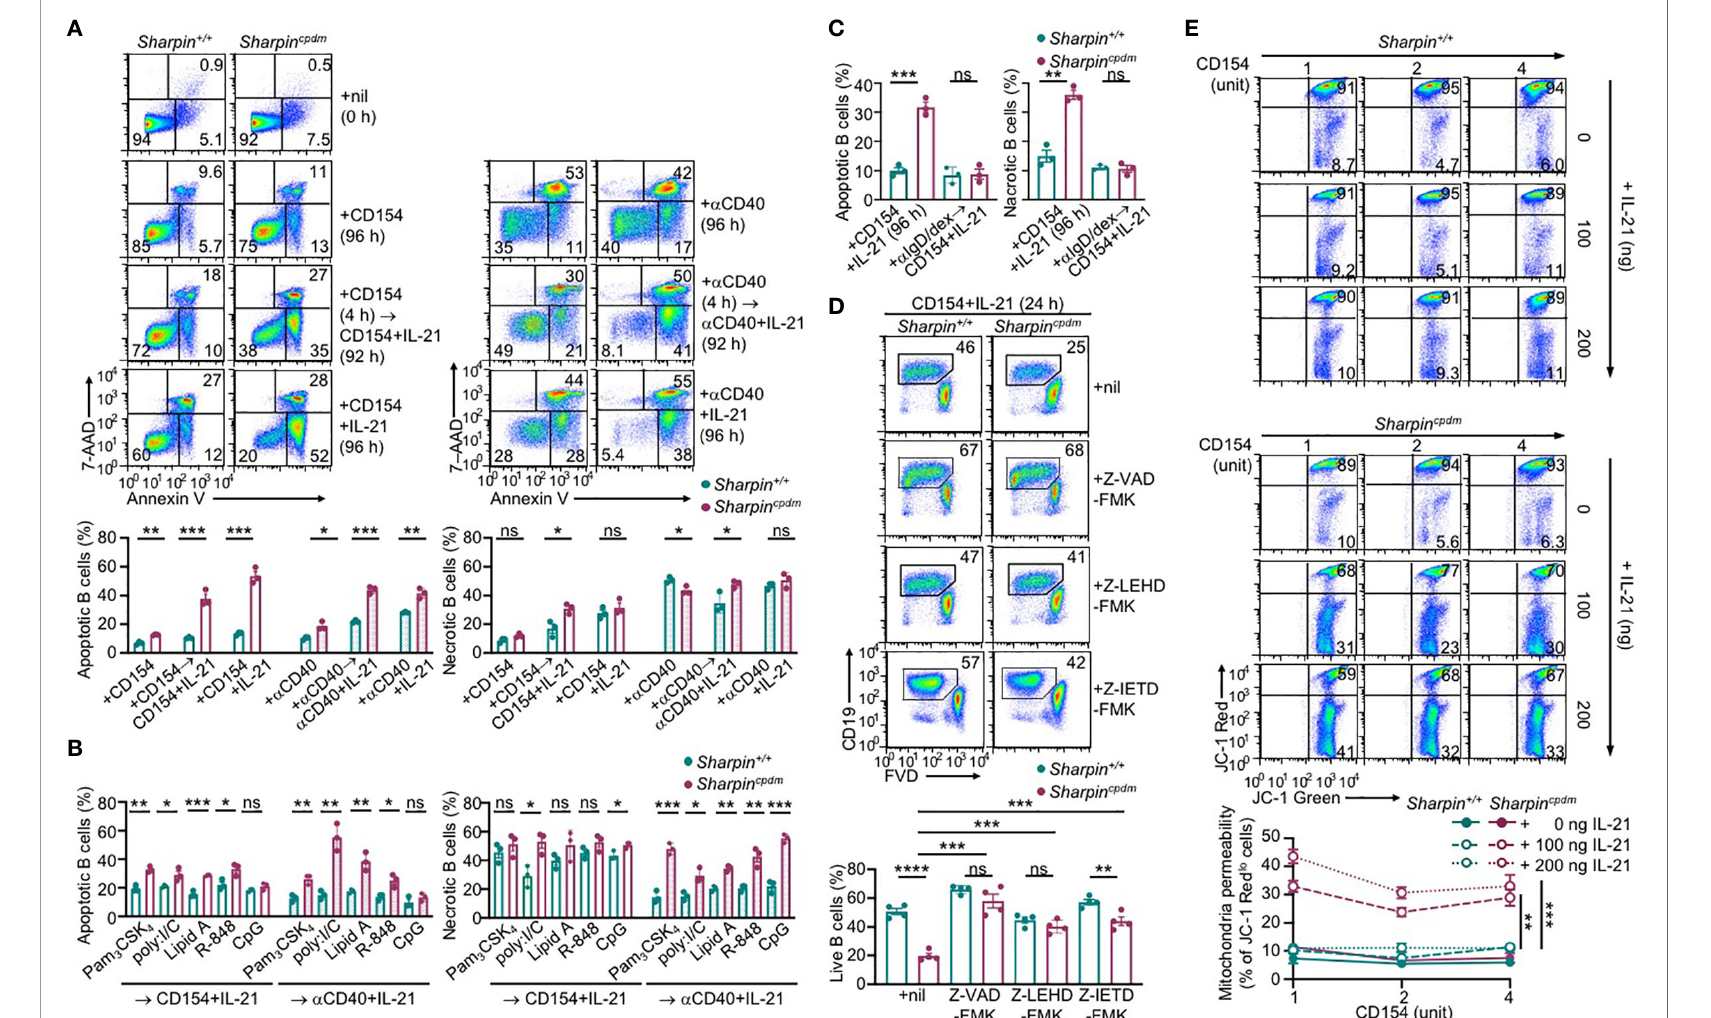
FIGURE 6 | SHARPIN inhibits IL-21-induced apoptosis in CD154-stimulated B cells. (A) Flow cytometry analysis of apoptosis (Annexin V + 7 – AAD lo ) and necrosis (Annexin V + 7 – AAD hi ) in freshly isolated Sharpin +/+ and Sharpin cpdm B cells or after stimulation with CD154 (left) or a CD40 (right) plus nil or IL-21 for 96 h, with or without priming with CD154 or a CD40 for 4 h. (B, C) Flow cytometry analysis of apoptosis and necrosis in Sharpin +/+ and Sharpin cpdm B cells after priming with TLR ligands (as indicated, B ) or a IgD/dex (C) for 4 h and then stimulated with CD154 or a CD40 plus IL-21 for 92 h. (D) Flow cytometry analysis of the viability of Sharpin +/+ and Sharpin cpdm B cells stimulated with CD154 plus IL-21 in the presence of nil or pan-caspase inhibitor Z-VAD-FMK, caspase 9-speci fi c inhibitor Z-LEHD-FMK or caspase 8-speci fi c inhibitor Z-IETD-FMK (all 20 m M). (E) Mitochondrial membrane potential in B cells stimulated with CD154 and IL-21 at indicated doses for 48 h (n=4, mean and s.e.m.; data at 4 units of CD154 were analyzed for statistical differences between Sharpin +/+ and Sharpin cpdm B cells). * p < 0.05; ** p <0.01; *** p < 0.001;